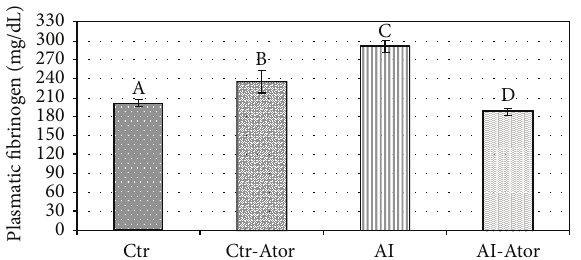
Figure 3: Enzymatic activity of SOD in ratswith induced HF treated with atorvastatin ( 𝑛 = 12 ). Crt versus Ctr.Ator ND; Ctr versus AI 𝑃 < 0.001 ; Ctr versus AI-Ator 𝑃 < 0.001 ; Ctr-Ator versus AI 𝑃 < 0.001 ; Ctr-Ator versus AI-Ator 𝑃 < 0.001 ; AI versus AI-Ator 𝑃 < 0.001